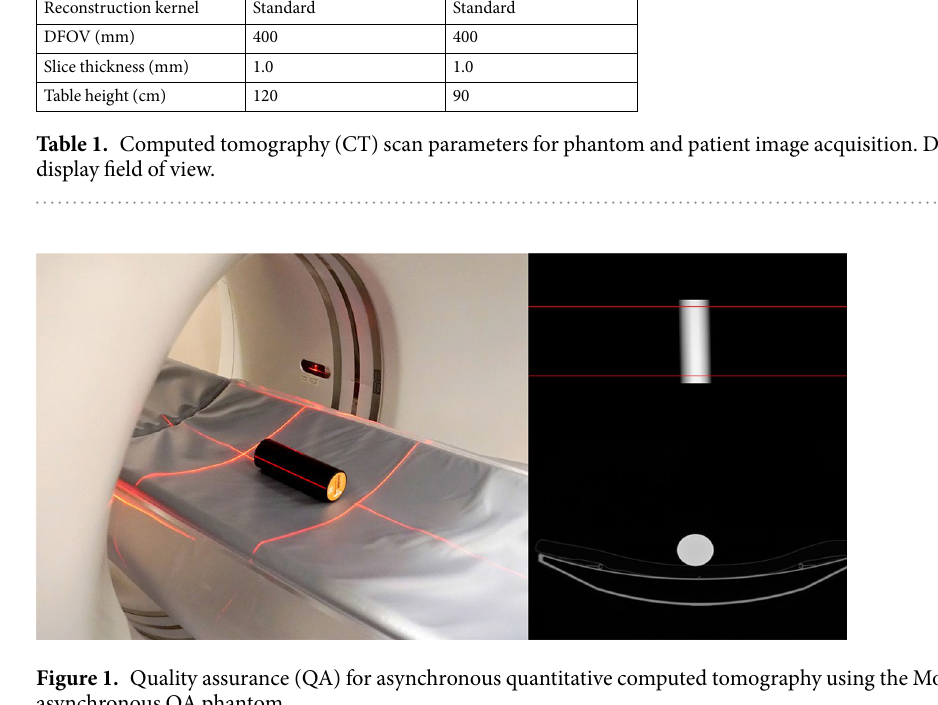
Figure 1. Quality assurance (QA) for asynchronous quantitative computed tomography using the Model 4 asynchronous QA